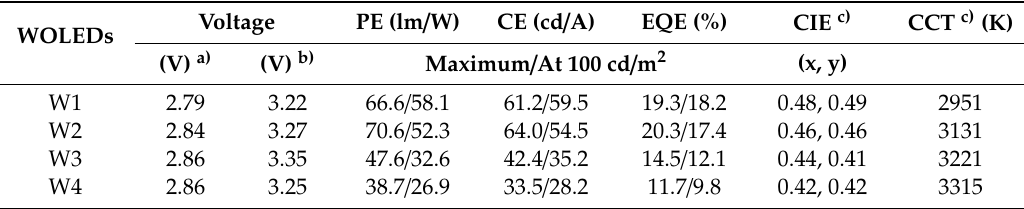
Table 1. Summary of voltages, power e ffi ciency (PE), current e ffi ciency (CE), external quantum e ffi ciency (EQE), Commission International de I’Eclairage (CIEs) coordinates, and color temperature (CCT) of the devices for W1 to W4. a), b) Voltages were measured corresponding to the onset